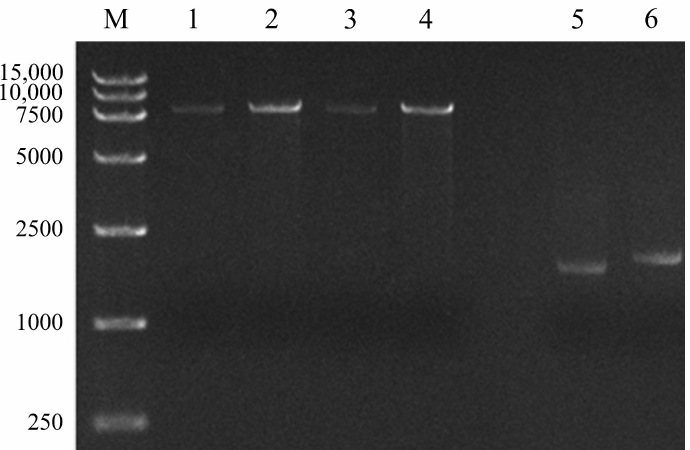
Figure 9. Verification of the recombinant plasmid pUCP18-Red and ∆ mo5660 mutant by enzyme digestion and PCR, respectively. M: DL15,000 DNA Marker. Lanes 1–4: Verification of the Red operon by Hind III digestion. Lanes 5 and 6: Verification of gene deletion using two primer pairs outF/kanRin and